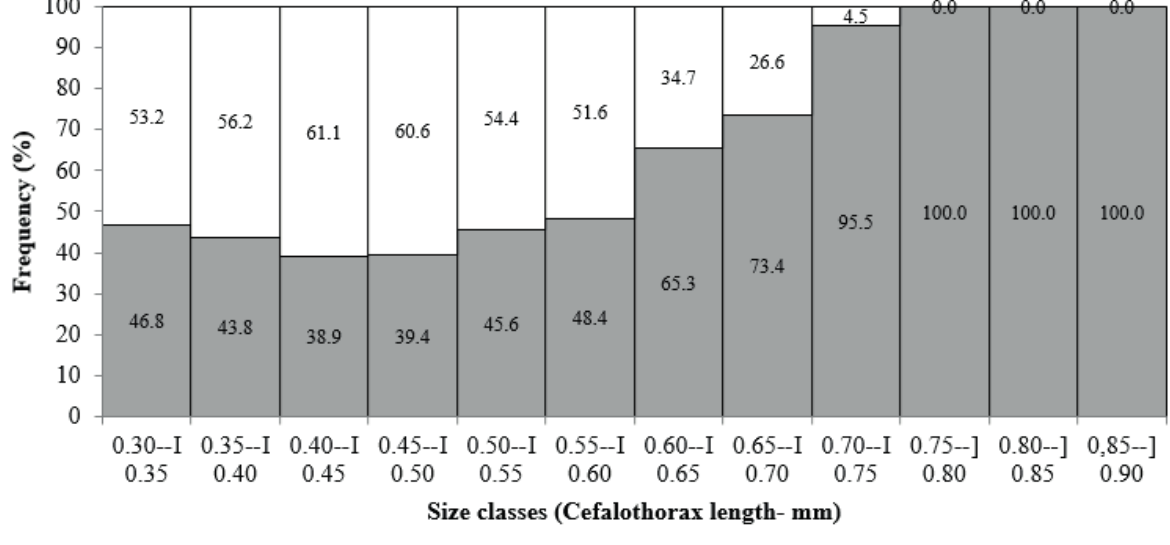
Figure 2. Sex ratio of Hyalella bonariensis by size classes of cephalothorax length (CL in mm), from Silveira Martins, state of Rio Grande do Sul, Brazil. “*” indicate signifi cant diff erence in sex ratio